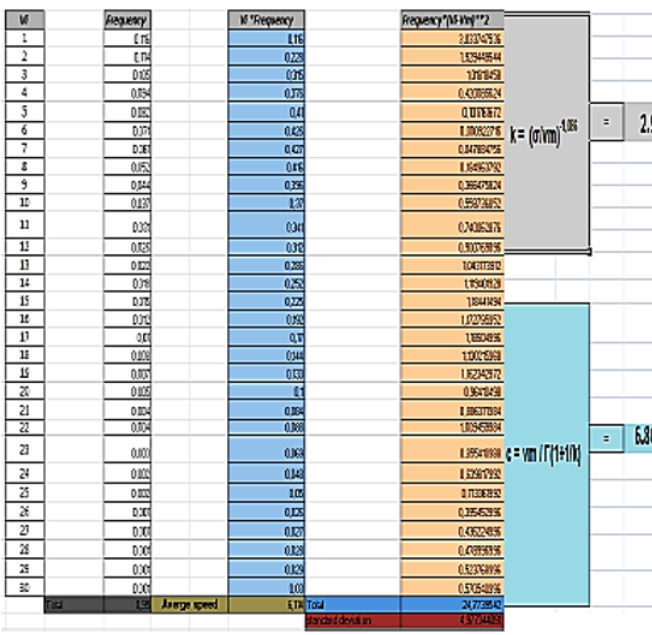
Table 3. Calculation of the Weibull parameters using the standard deviation method for the Laayoune